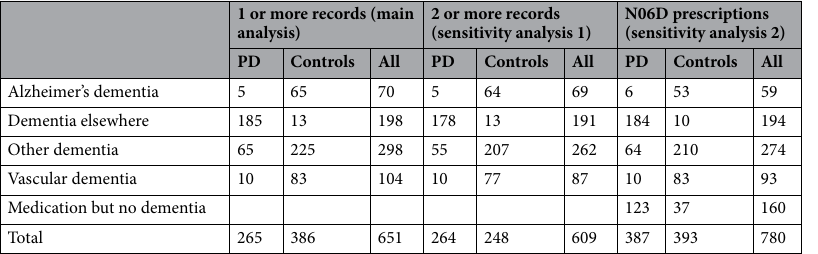
Table 2. Frequency of dementia, by dementia category.